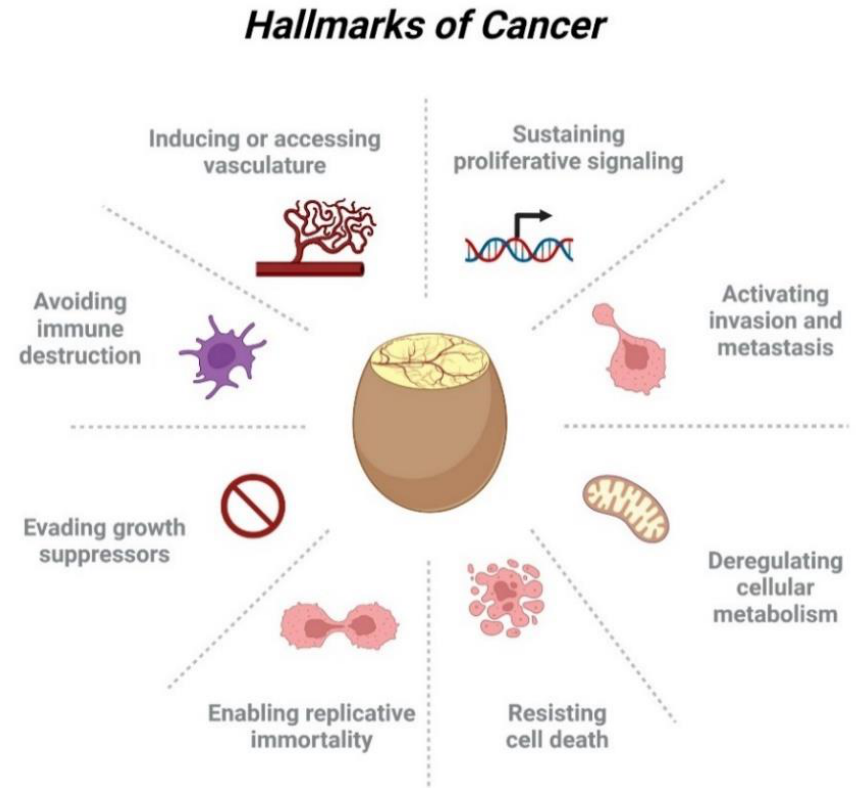
Figure 2. The CAM model and the eight core hallmarks of cancer.